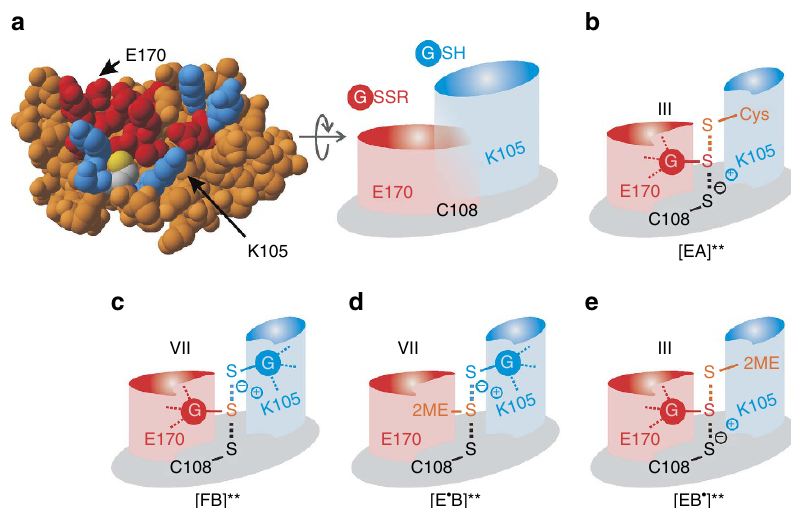
Figure 6 | Model of the glutathione scaffold and glutathione activator site with implications for relevant transition states. ( a ) Residues of the glutathione-scaffold site (including confirmed Glu170) and the potential glutathione activator site (including confirmed Lys105) both face the active site cysteine residue and are highlighted in red and blue, respectively. A schematic representation of both sites at the enzyme surface is shown on the right side of the panel. ( b – e ) Proposed transition states for the GSH-dependent turnover of the model substrates GSSCys and HEDS. Transition states [EA]** with GSSCys in b and [EB (cid:3) ]** with GSSEtOH in e both correspond to species III of the original glutathione-scaffold model 12 and yield the glutathionylated enzyme ‘F’. Transition state [FB]** with GSSG in c and the HEDS-derived transition state [E (cid:3) B]** with GSSEtOH in d correspond to species VII of the original activator model 12 with a glutathione and a non-glutathione disulfide substrate, respectively. Please note that the glutathionylated enzyme ‘F’ cannot be directly formed from [E (cid:3) B]** in d because of geometric constraints that prevent a direct attack of GS (cid:2) at the active site cysteine. The product GSSEtOH first has to change its orientation, as shown in e , before it serves as a substrate yielding glutathionylated enzyme